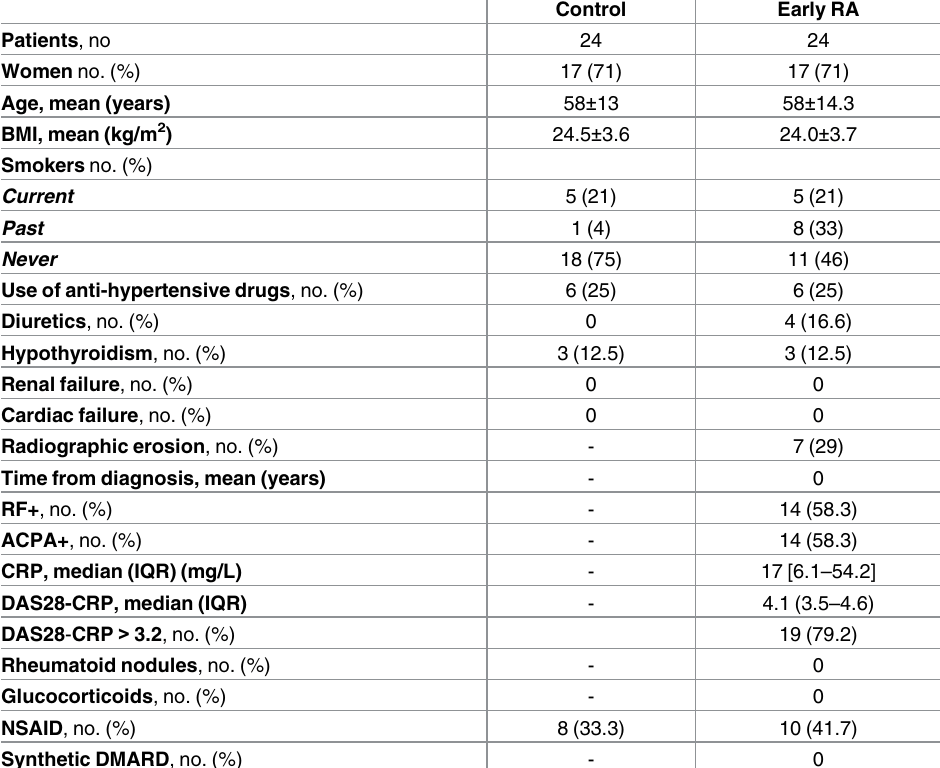
Table 1. Baseline characteristics of patients with RA at diagnosis (early RA) and matched